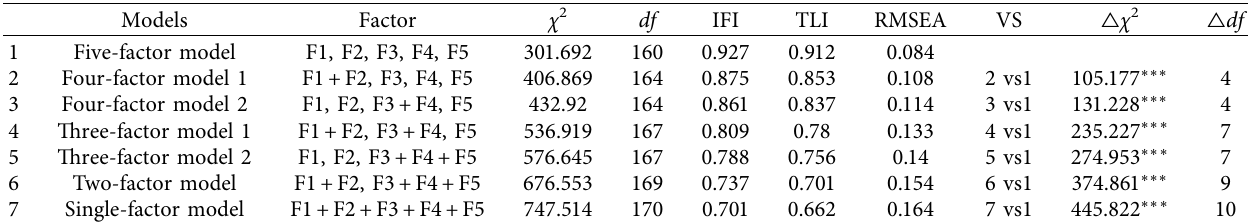
Table 3: Variable validity test.